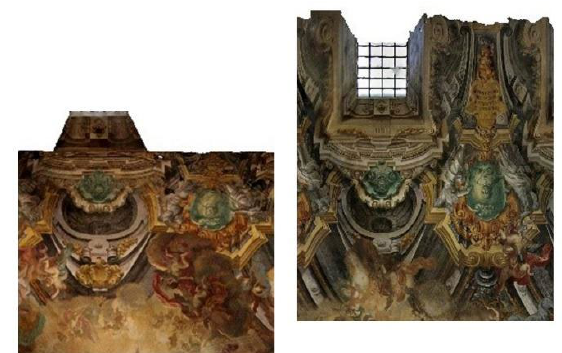
Figure 10. Difference between orthogonal projection and cylindrical